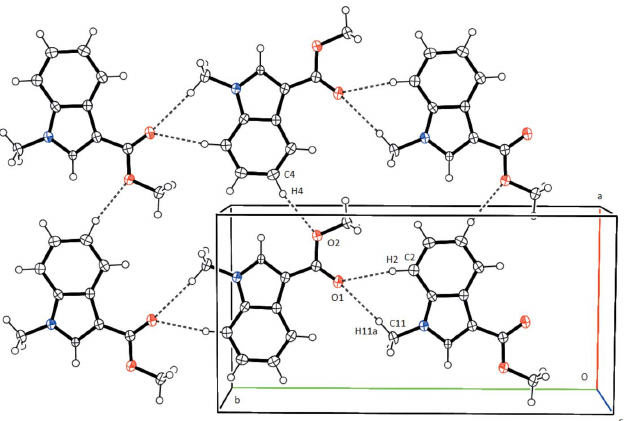
Figure 3 Part of the crystal packing showing the C—H (cid:2)(cid:2)(cid:2) (cid:2) stacking interactions. Cg 1 is the centroid of the C1–C6 ring.